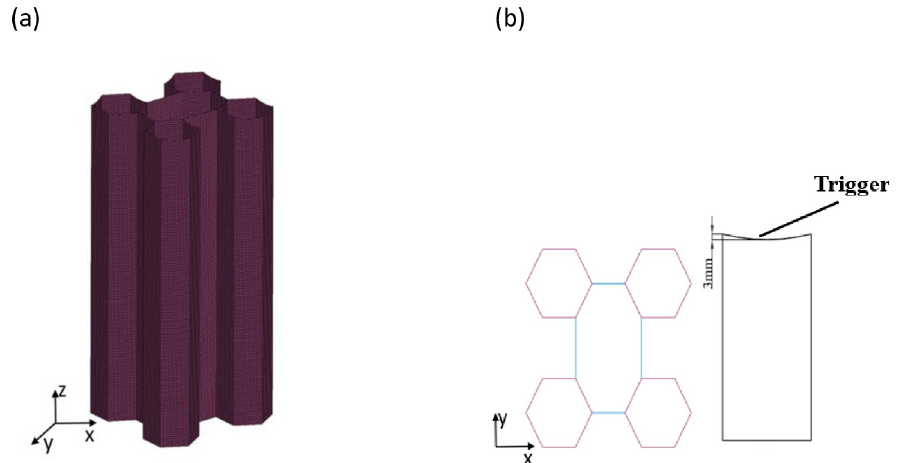
Fig 7. (a) Finite element model of the five multi-cell tube; (b) The trigger used in the study.